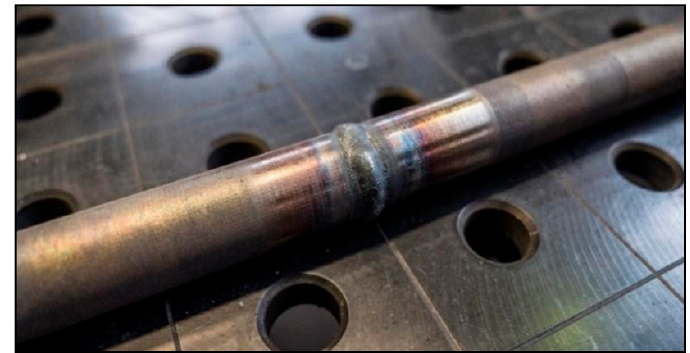
Figure 3. Welded joint No. 1.